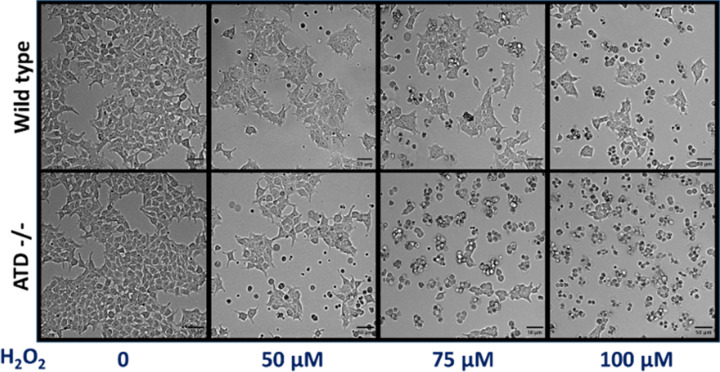
ATD knockout cells are sensitive to oxidative stress.Microscopic images showing the higher cell death in ATD knockout cells compared to wild type cells when treated with different concentrations of H2O2.